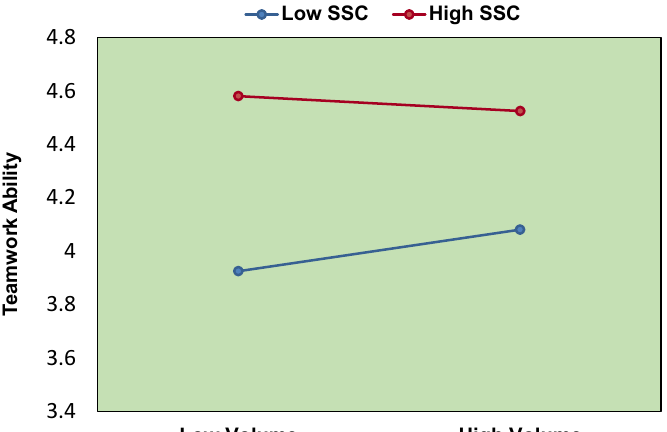
Figure 3. The moderating effect of SSC.